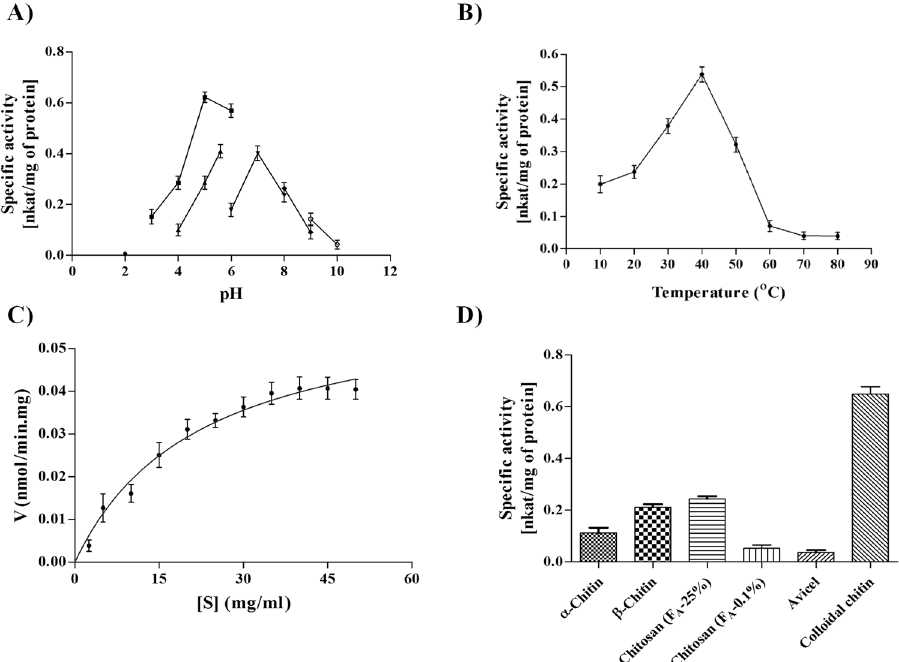
Figure 1. pH, temperature optima, kinetic parameters and activity on different insoluble substrates of Ec Chi1. The pH and temperature optima were determined by incubating 30 mg/ml colloidal chitin and 30 μ g of Ec Chi1 for 1 h at 40 °C in various buffers at different pH values, as follows: ( A ) 50 mM glycine-HCl (pH 2.0, ▼ ), 50 mM sodium citrate (pH 3.0–6.0, ■ ), 50 mM sodium acetate (pH 4.0–6.0, ▲ ), 50 mM sodium phosphate (pH 6.0– 8.00, ● ), 50 mM Tris-HCl (pH 8.0–9.0, ♦ ) and 50 mM glycine-NaOH (pH 9.0–10.0, ○ ) and at 10 °C to 80 °C ( B ), Different concentrations of colloidal chitin (2.5–60 mg/ml) and 30 μ g of Ec Chi1 in 50 mM sodium citrate buffer, pH 5.0. The average of the triplicate data was fitted to the Michaelis-Menten equation by a nonlinear regression function of graphpad prism version 6.0 ( C ), The reaction mixture containing 30 μ g Ec Chi1 and 1 mg ml − 1 of one of the polymeric substrates, was incubated at pH 5.0 and 40 °C for 1 h. The reaction mixture was centrifuged, and products were quantified using a reducing group assay ( D ). The error bars represent the standard deviations from three individual experiments.